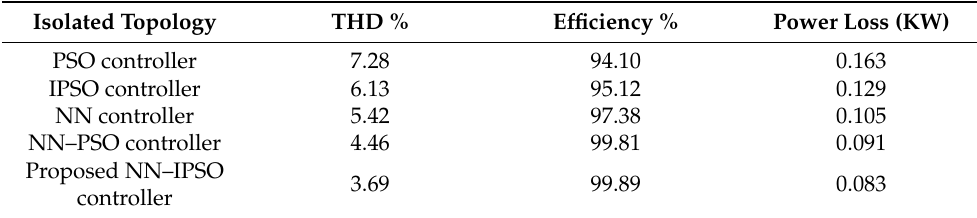
Table 2. Performance of various controllers.